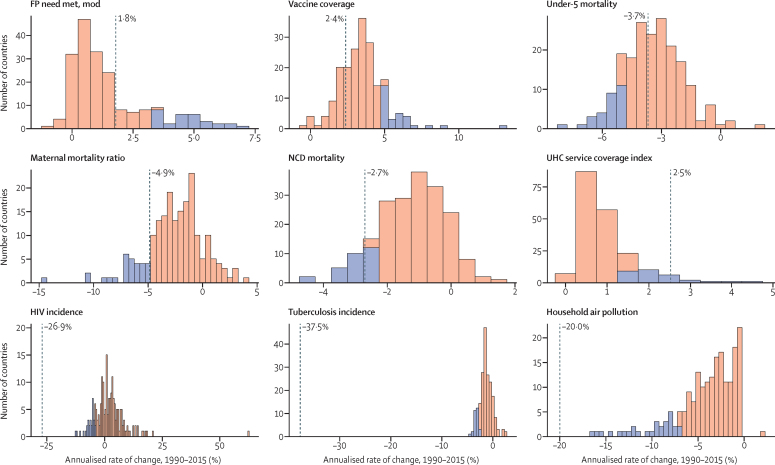
Global annualised rate of change required to meet selected SDG targets based on annualised rate of change achieved by countries or territories, 1990–2015For the 25 SDG indicators with defined targets, we estimated the required global annualised rate of change (dotted line) required to meet each target using the global average in 2015 and specific thresholds to be met by 2030 or relative reductions to be achieved by 2030. The top performing decile (the 10th decile) is shown in blue and all other annualised rates of change are shown in red. A subset of SDG indicators with defined targets are shown here; the remaining plots can be found in appendix 2. Definitions of health-related SDG indicators and targets associated with them are shown in table 1. FP need met, mod=family planning need met with modern contraceptive methods. NCD=non-communicable disease. SDG=Sustainable Development Goal. UHC=universal health coverage.